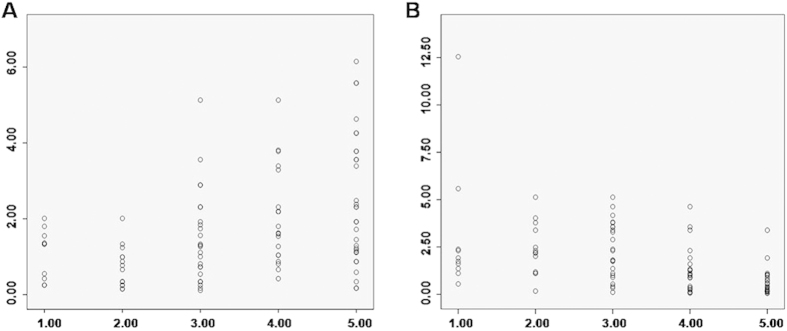
Correlation analysis of elasticity scores and α-SMA (A) and CD34 (B) expressions in breast lesions.